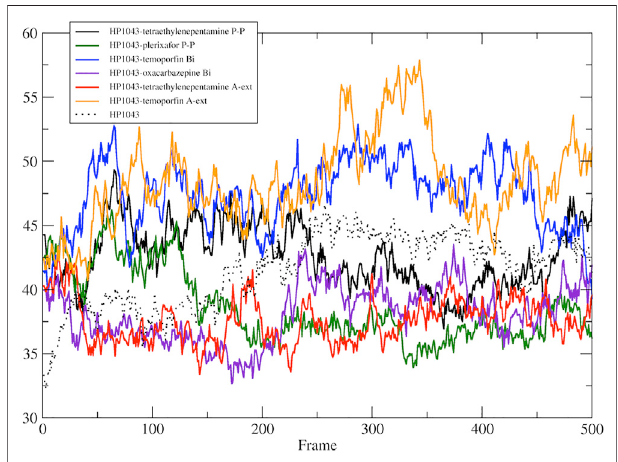
FIGURE 5 | DNA-binding domain distance in the free form. Distance between the center of mass of DNA-binding domain of A chain and B